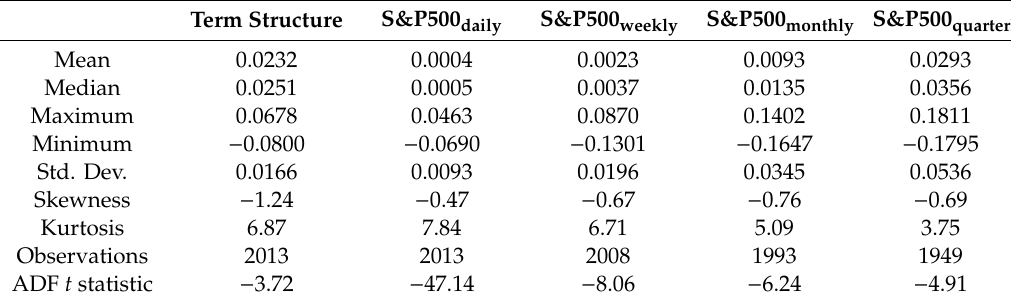
Table 1. Descriptive statistics of the VIX futures term structure and S&P500 returns.